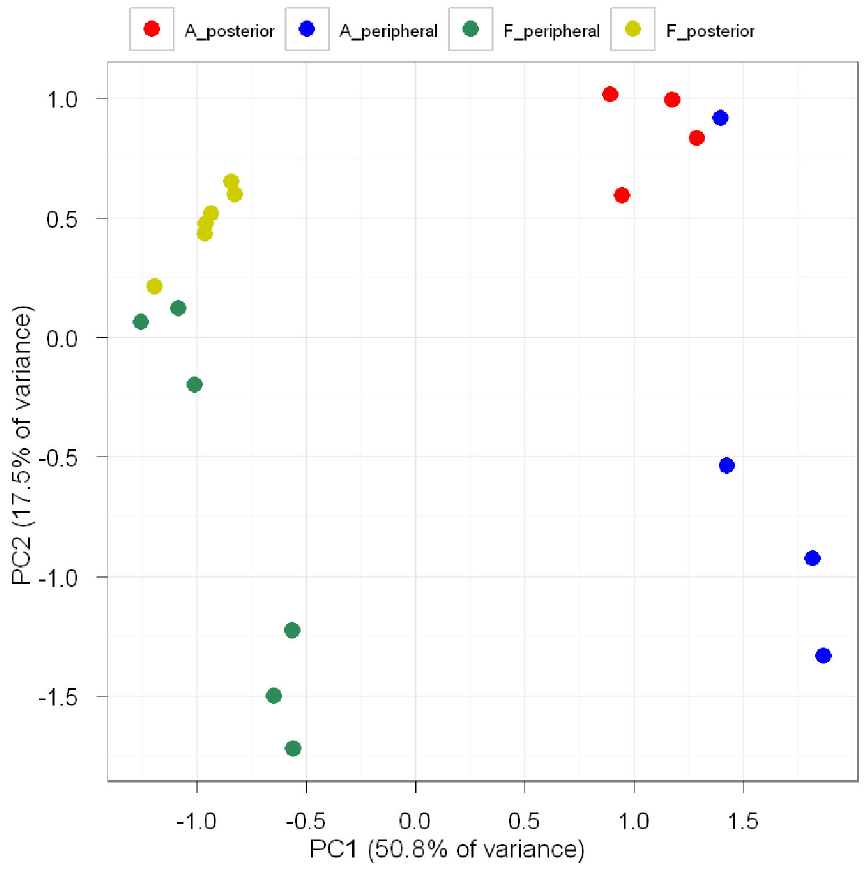
Figure 2. The PCA plot illustrating the correlation of expression between samples. Clustering on the PCA plot indicates a strong correlation. The x-axis shows the first principal component (PC1) revealing variations of expression between ‘adult’ and ‘fetal’ groups. The y-axis shows the second principal component (PC2) revealing variations of expression between ‘posterior’ and ‘peripheral’